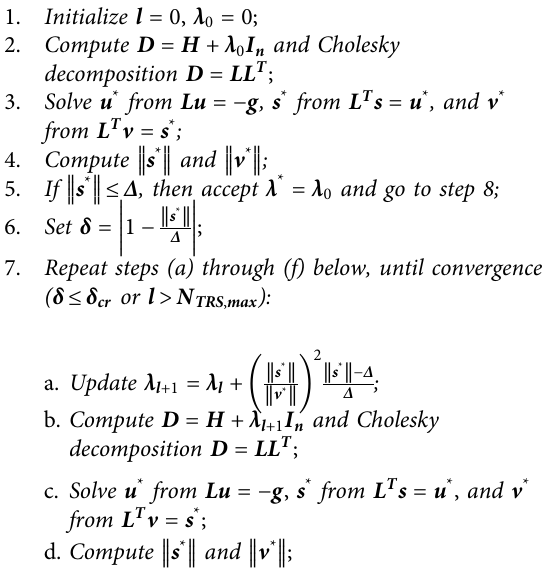
Algorithm-2: Solving the L-BFGS TRS Using the